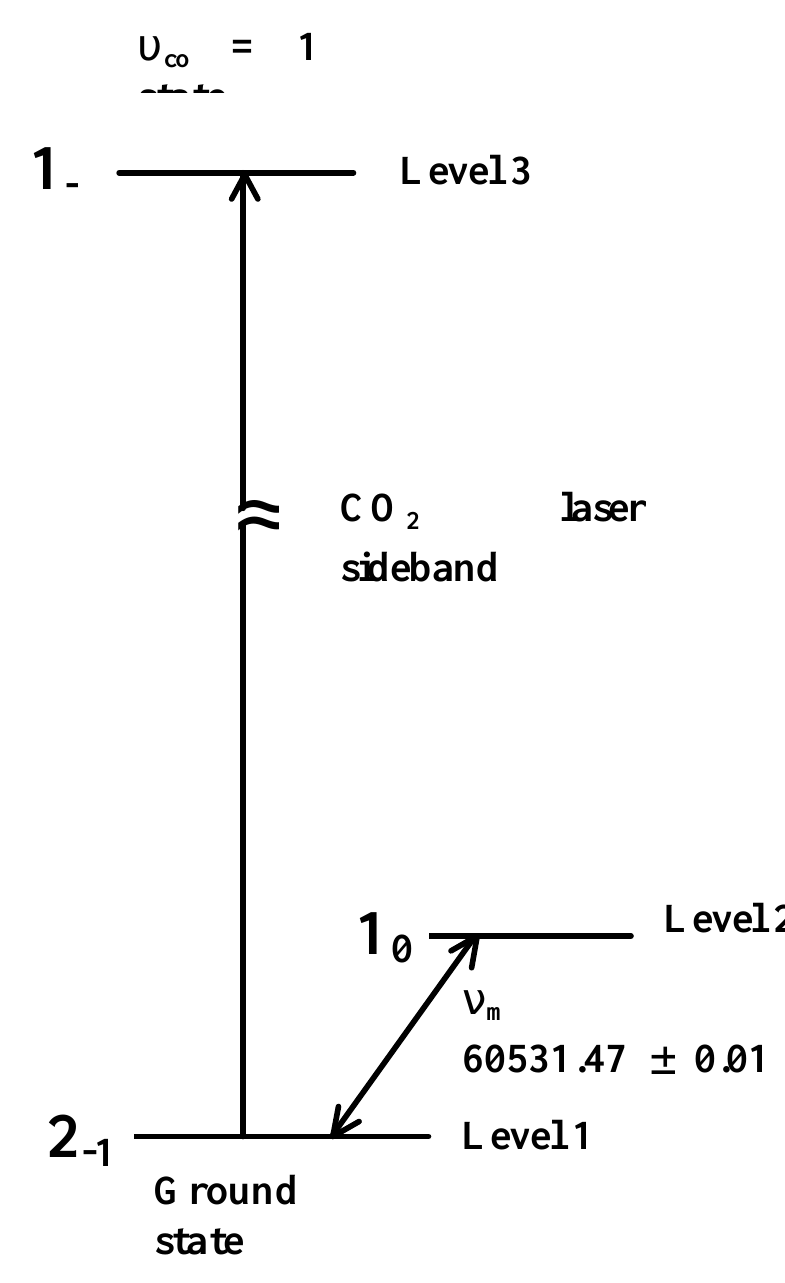
Figure 4. Energy levels relevant to the signal shown in Figure